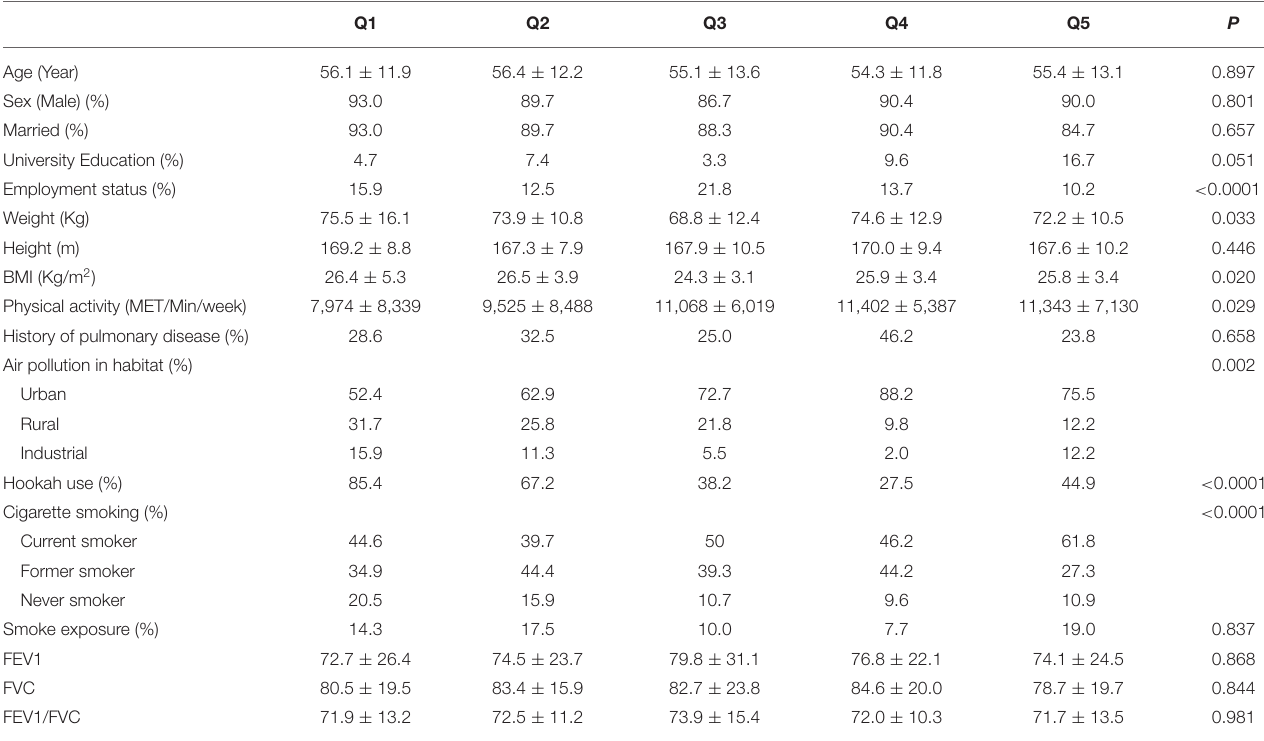
TABLE 3 | Characteristics of study participants among quintiles of LCD score. Q1 Q2